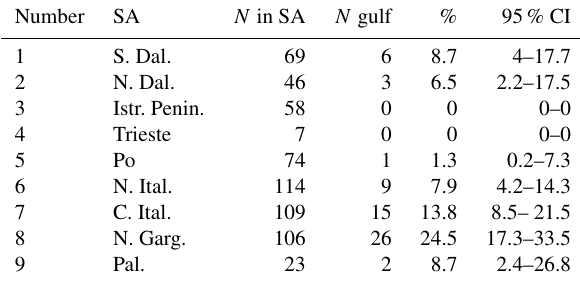
Table 1. Connection of SAs with the Gulf of Manfredonia estimated by drifters. Columns 1 and 2 indicate the number and name of each SA (see Fig. 1b for locations). Column 3 indicates the total number ( N ) of drifters that entered or were launched in a given SA, while column 4 indicates the number of drifters that continued from the SA to the Gulf of Manfredonia ( N gulf). The percentage (%) of N gulf drifters with respect to N is shown in column 5. Column 6 shows the 95% confidence intervals estimated using the Wilson